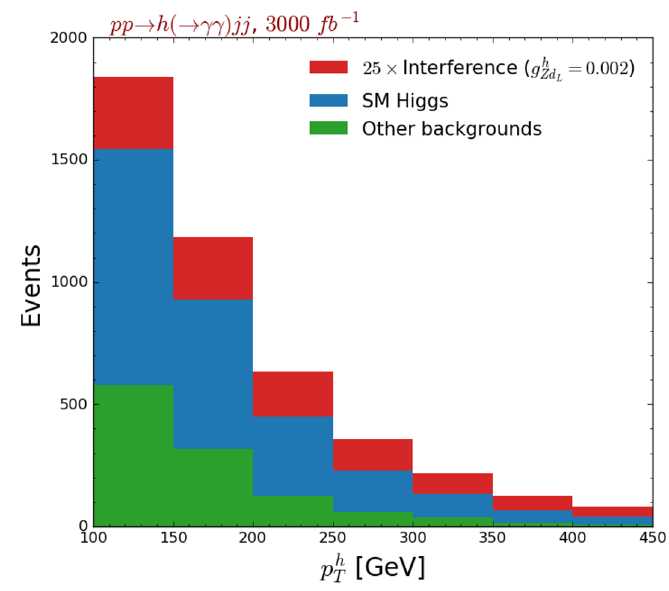
Figure 3 . The final distribution with respect to the transverse momentum of the Higgs boson, p h , T for all the events in the diphoton channel that survive NN classification. The red represents the EFT interference contribution; blue represents the SM VBF Higgs contribution and green shows the other background sources which are all presented with 3 ab − 1 data. The EFT contribution corresponds to interference coming from g h = 0 . 002 amplified 25 folds and with vanishing values Zd L for all other anomalous couplings in eq.